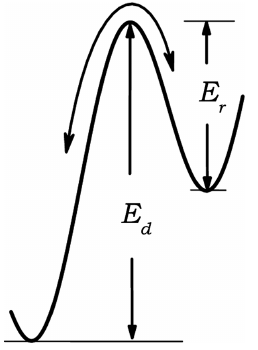
Figure 3 Two-level potential for sites